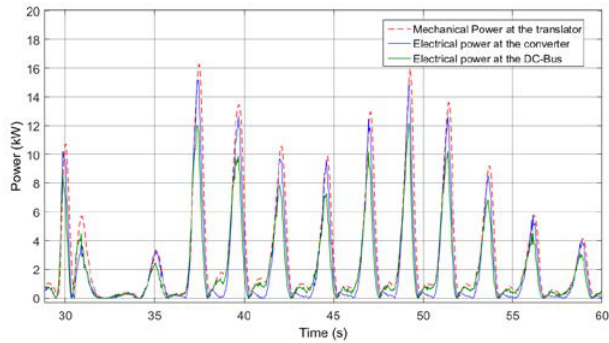
Fig. 15. Power captured from the PTO and delivered DC-bus power in Case III.